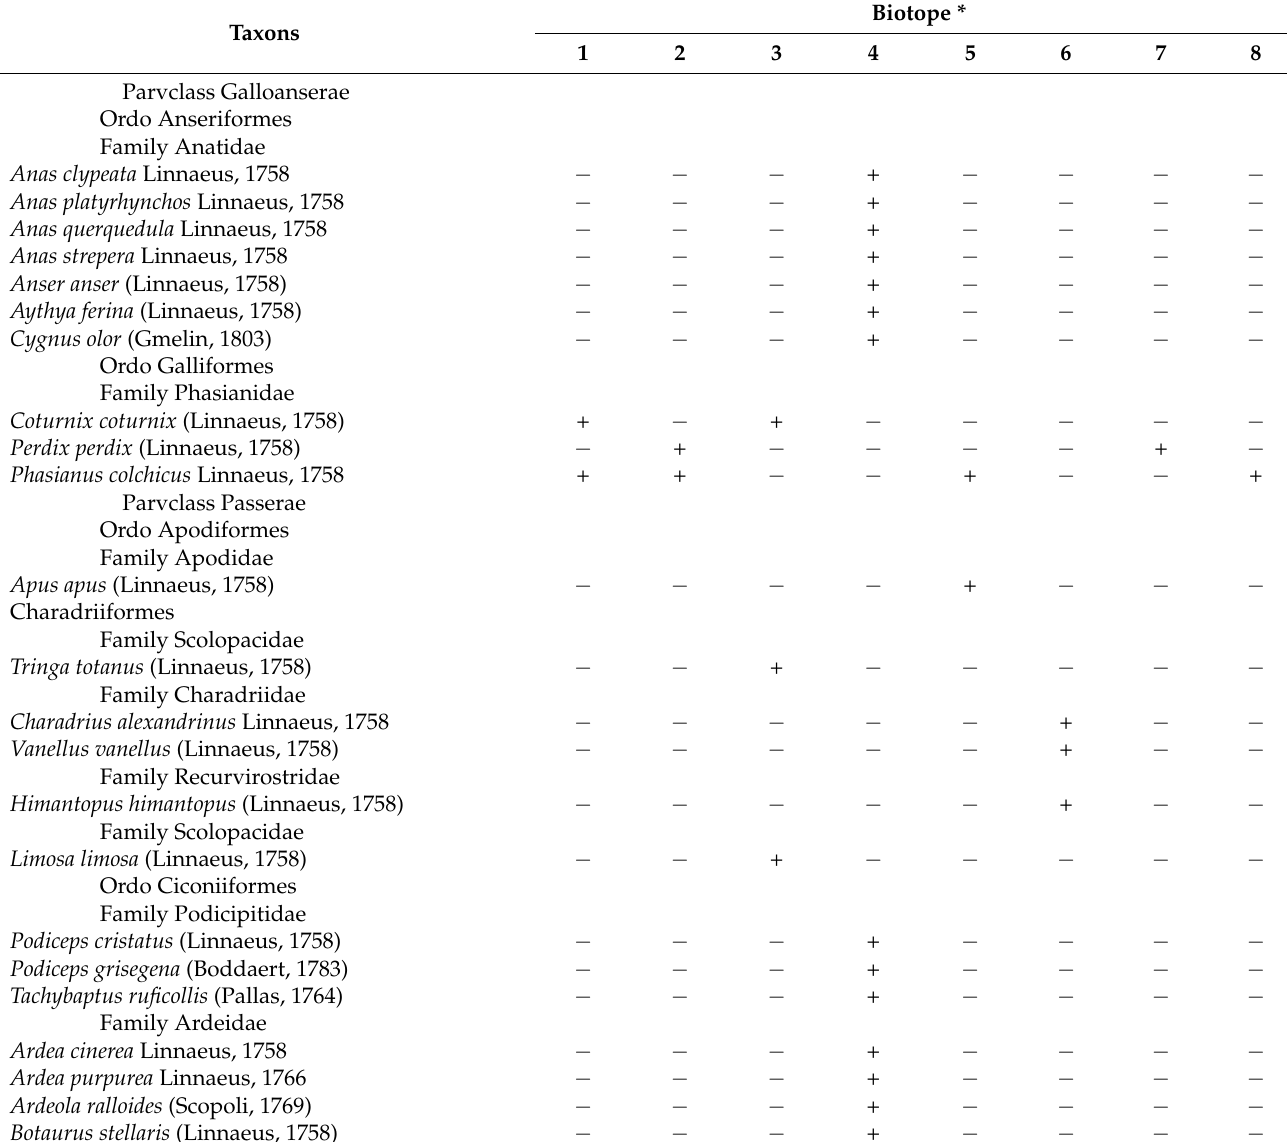
Table A2. Taxonomic diversity and presence/absence (+/ − ) of the aviafauna species (Class Aves).